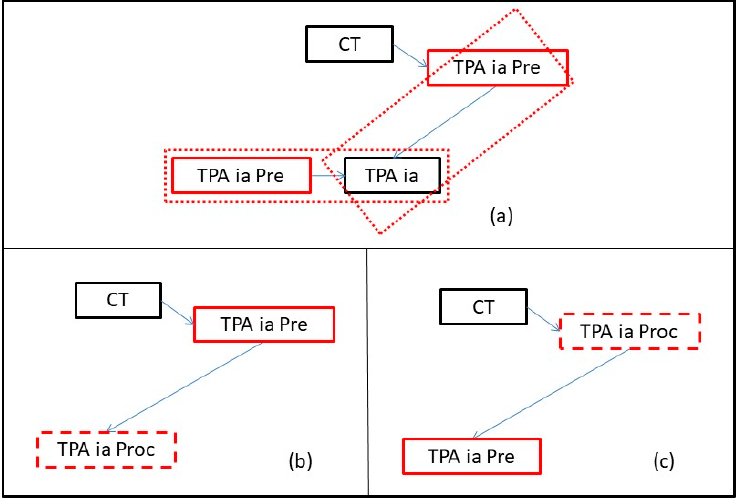
Figure 9. Conflict situation, with red boxes indicating the two conflicting abstractions ( a ) and possible solutions ( b , c ).